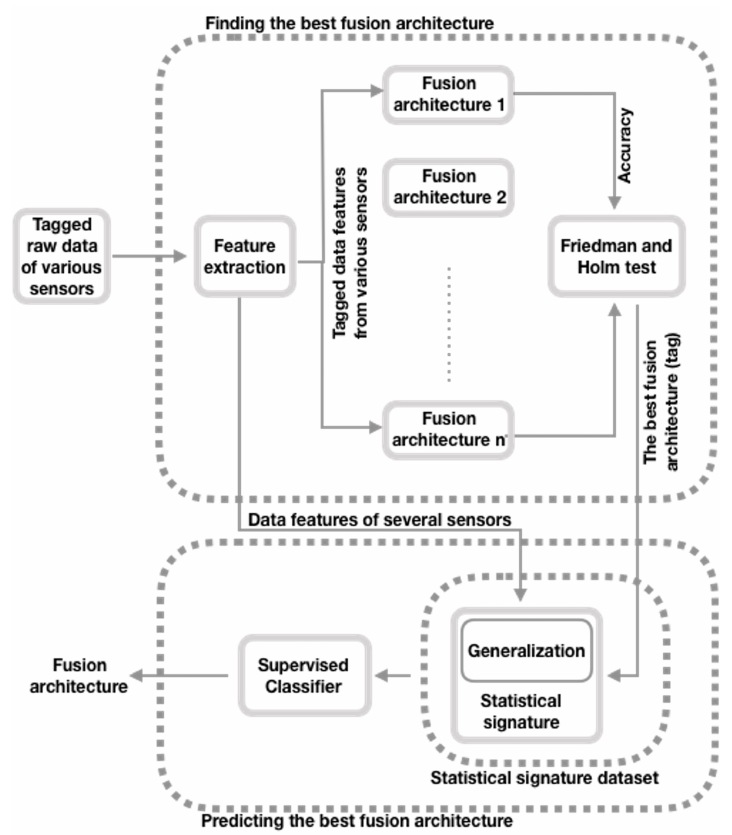
Figure 1. General schematic of the enhanced approach that identifies the optimal fusion architecture (adapted from Brena et al.